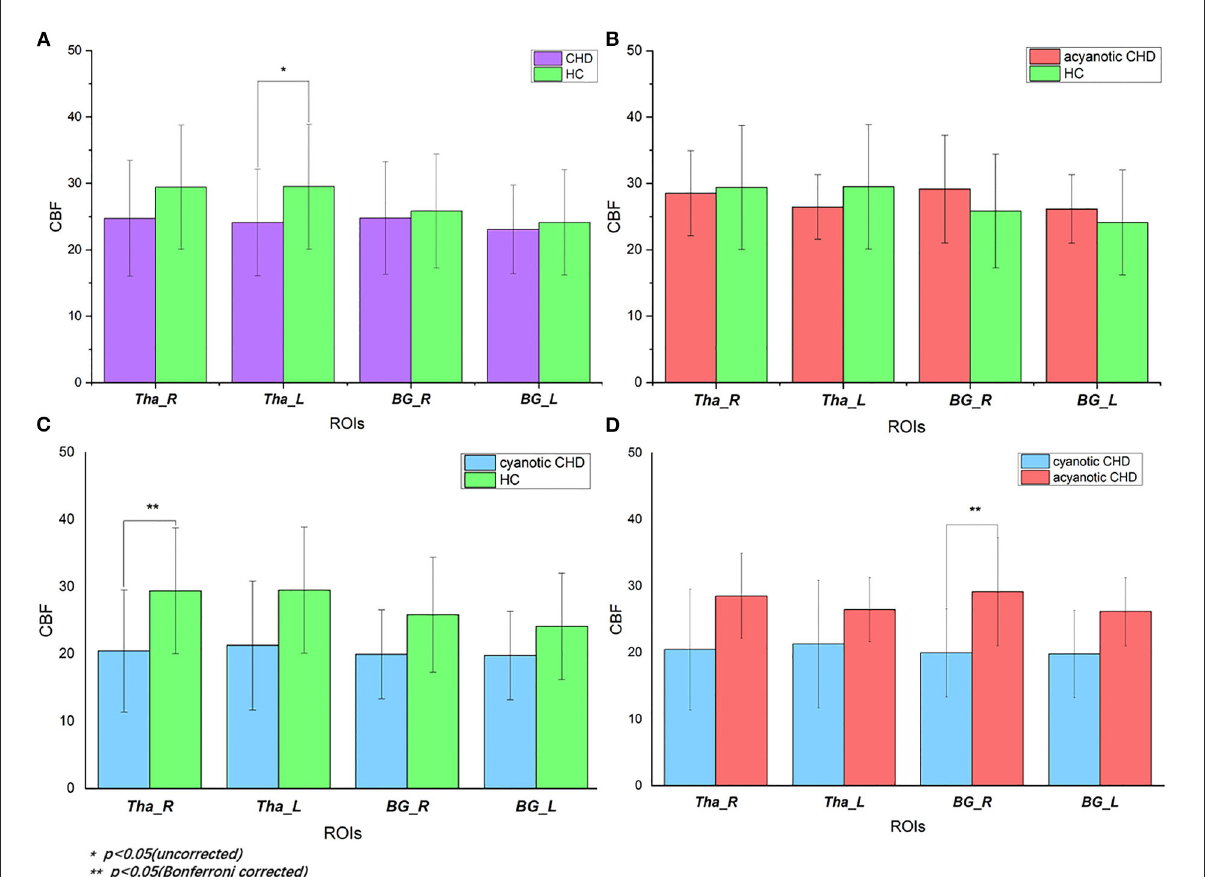
FIGURE3 Regional CBF of deep gray matter in CHD and control subjects: (A) CBF values in CHD neonates vs. controls. When CHD group was assessed as a whole, it showed decreased CBF of left thalamus ( p = 0.049) compared with controls. After FDR correction, there was no statistical difference. (B) CBF values in acyanotic CHD vs. controls. There was no statistically significant difference; (C) CBF values in cyanotic vs. controls. There was decreased CBF in right thalamus ( p = 0.036) in cyanotic CHD newborns when compared with controls; (D) CBF values in cyanotic vs. acyanotic CHD. It showed lower right BG CBF ( p = 0.042) in the cyanotic newborns compared with acyanotic newborns. HC, healthy controls; CHD, congenital heart disease; CBF, cerebral blood perfusion; Tha_R, right thalamus; Tha_L, left thalamus; BG_R, right basal ganglia; BG_L, left basal